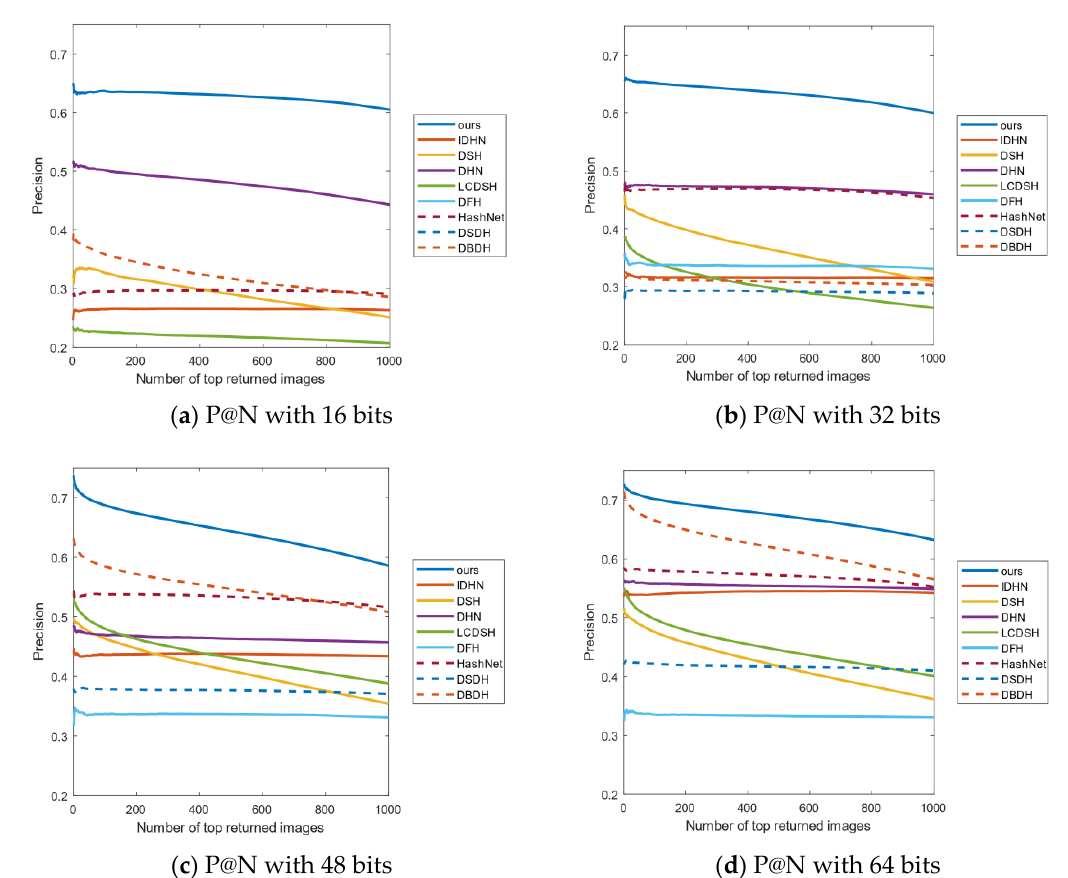
Figure 9. ( a – d ) represent the P@N curves on Imagenet-100 of all the algorithms when the length of the hash code is 16, 32, 48 and 64 bits, respectively.